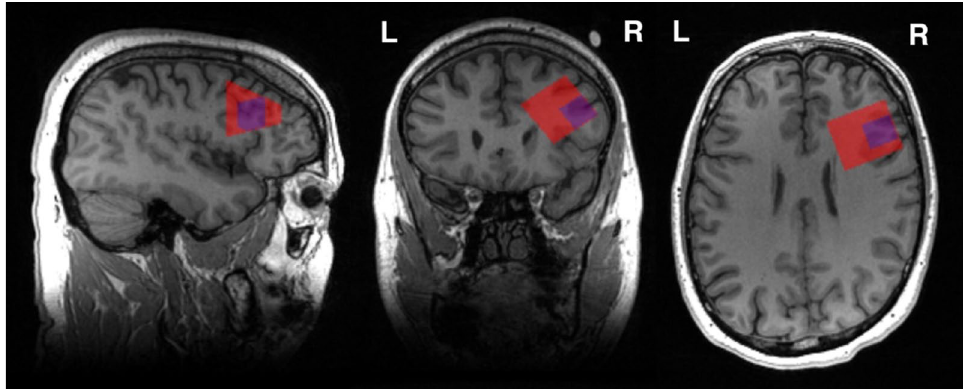
Figure 1. An example voxel placement of the large, red, and small, purple, voxels in the right